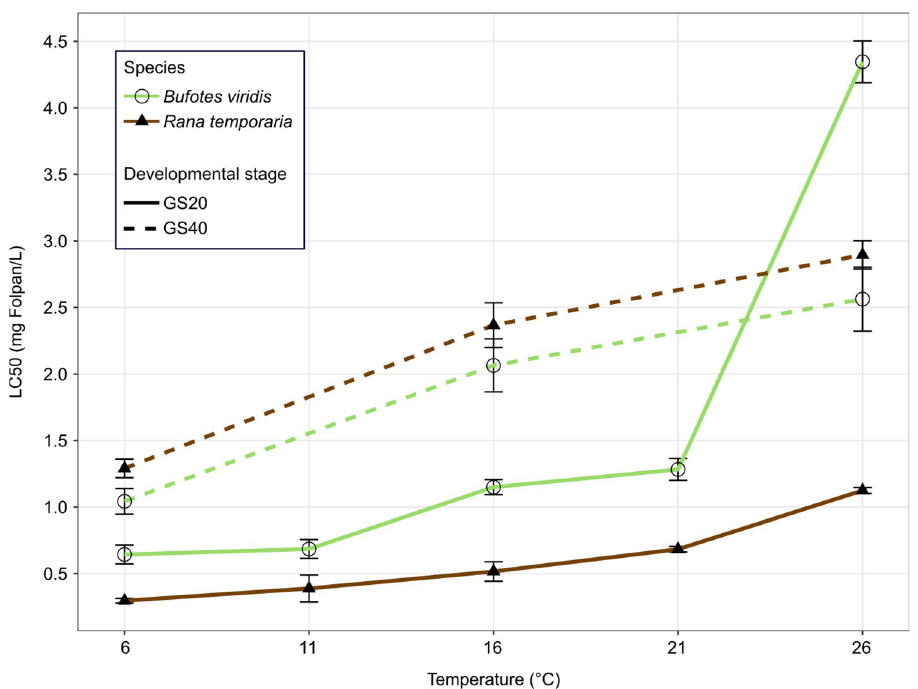
Fig 1. Calculated Folpan 1 500 SC 48h-LC 50 values ( ± 95% CI) of early (GS20) and late (GS40) developmental stages of R . temporaria and B . viridis at different temperatures. For detailed values and differences between temperatures see Table 1.